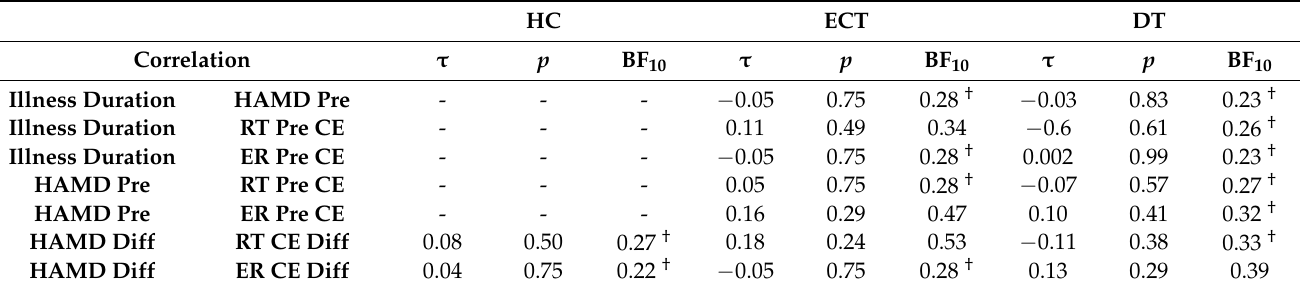
Table 6. Coefficients estimated using frequentist and Bayesian nonparametric (Kendall’s tau) and Bayesian correlation analyses among illness duration, clinical symptomatology, and attention performance. HC ECT